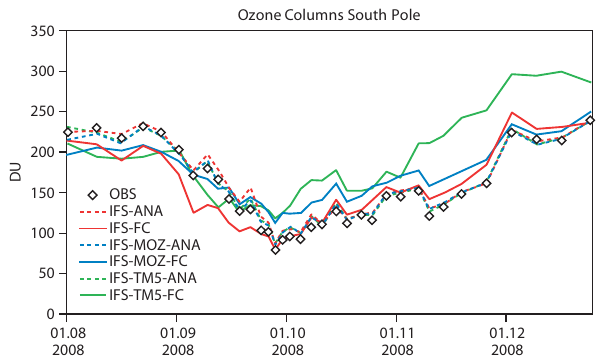
Fig. 6. Time series of observed total columns (OBS) inDU, y-axis, from ozone sondes at South Pole Station and from forecasts without (FC) and with assimilation (ANA) by IFS-MOZRT, IFS-TM5 and IFS. Only soundings whose top pressure was between 5 and 8.5hPa are